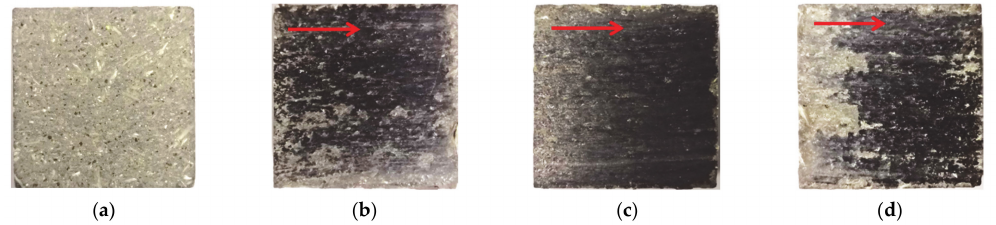
Figure 15. Morphologies of brake shoe specimens with different numbers of emergency braking cycles (the red arrow represents the sliding direction of the brake disc). ( a ) Original surface ( b ) after 5 cycles ( c ) after 10 cycles ( d ) after 20 cycles.